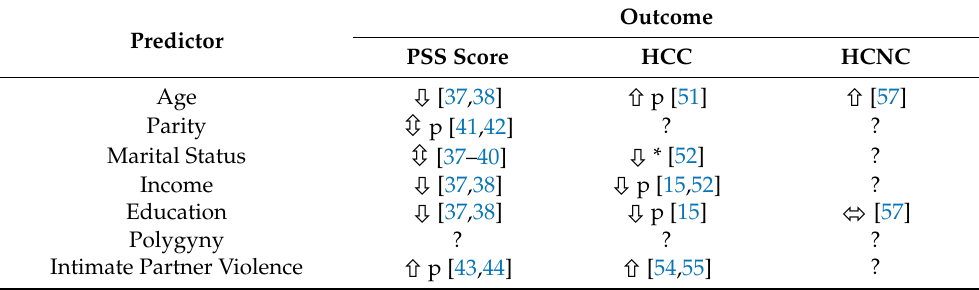
Table 1. Existing associations of sociodemographic factors with psychological and biological measures.